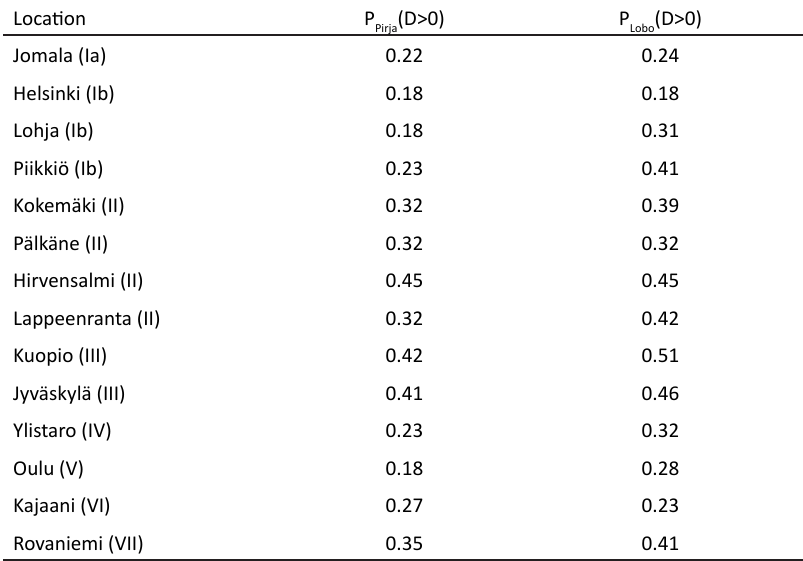
Table 1. The probability that the number of “infection days” in a year (D) is higher than zero in the studied geographical locations for the cultivars Pirja (P growth zones of the locations are shown in brackets.